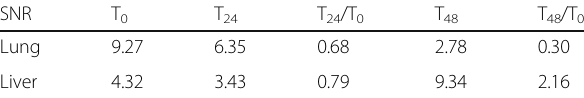
Table 2 Number of rats imaged at magnetic resonance Table 4 Signal-to-noise ratios (SNR) averaged among all imaging and sacrificed (in parentheses) at different time points examined animals after the injection of perfluorocarbon-labelled after injection of labelled mesenchymal stromal cells mesenchymal stromal Number of rats